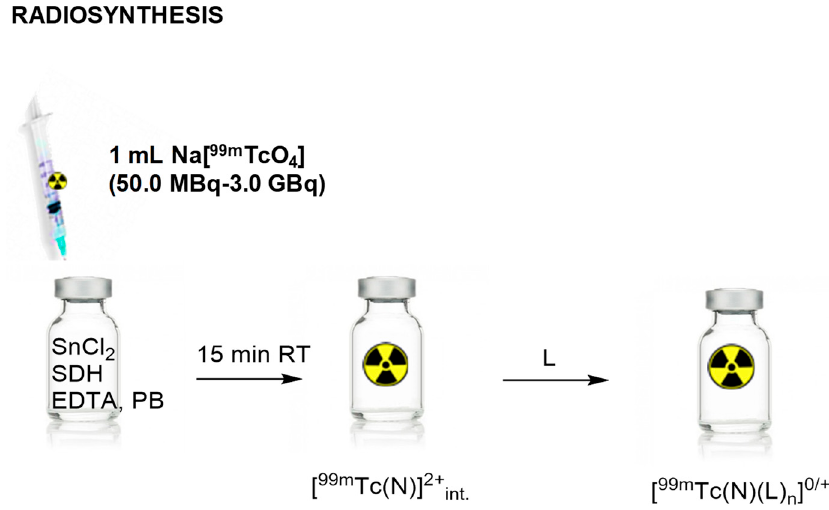
Figure 11. Preparation of [ 99m Tc][Tc ≡ N]–RPs, (L = selected coordinating ligand).